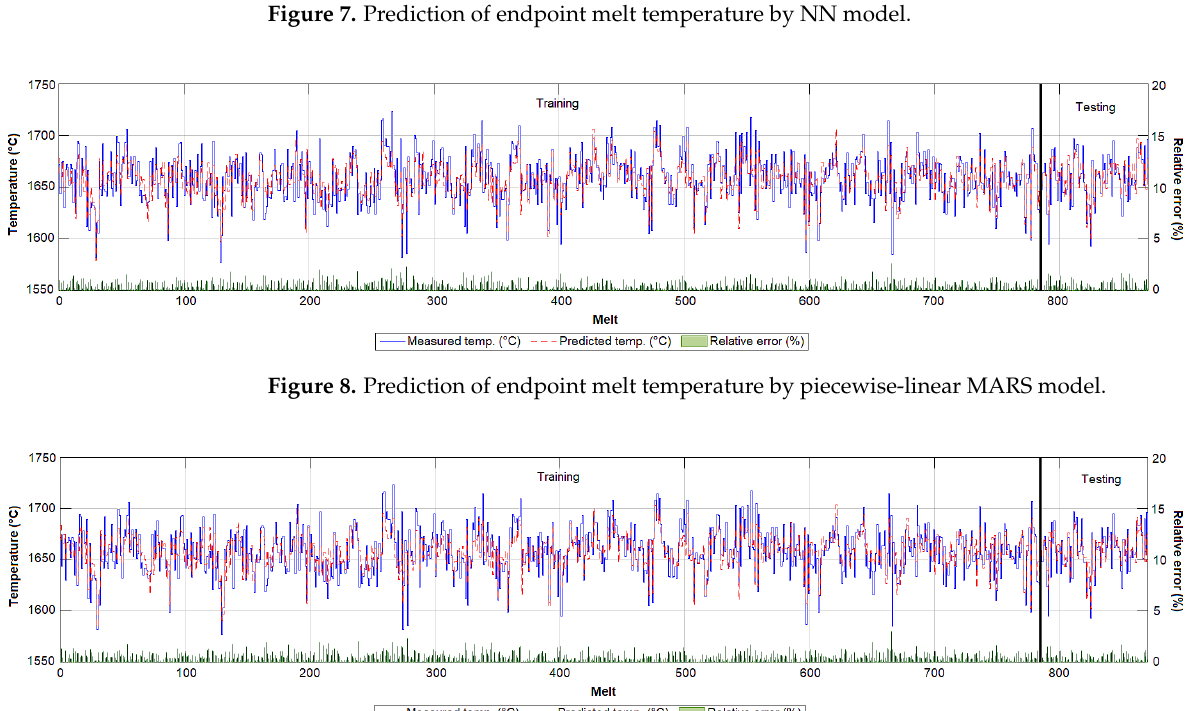
Figure 7. Prediction of endpoint melt temperature by NN model.